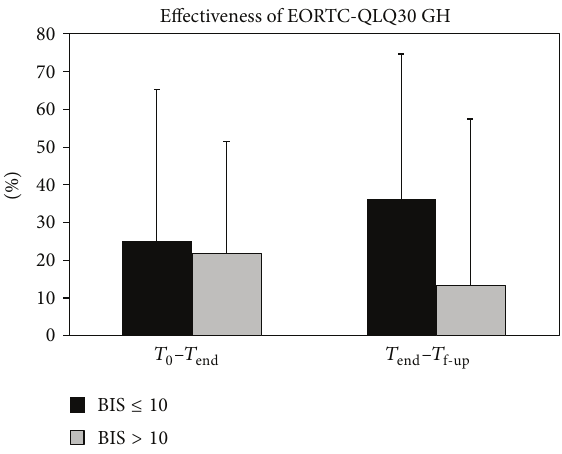
Figure 3: Mean and standard deviation of the effectiveness of the treatment in terms of EORTC QLQ 30 Global Health: EORTC Quality of Life core questionnaire in the treatment period (on the left) and during the follow-up period (on the right) for the patients with Body Image Scale (BIS) scores ≤ 10 (black bars) and > 10 (grey bars) at